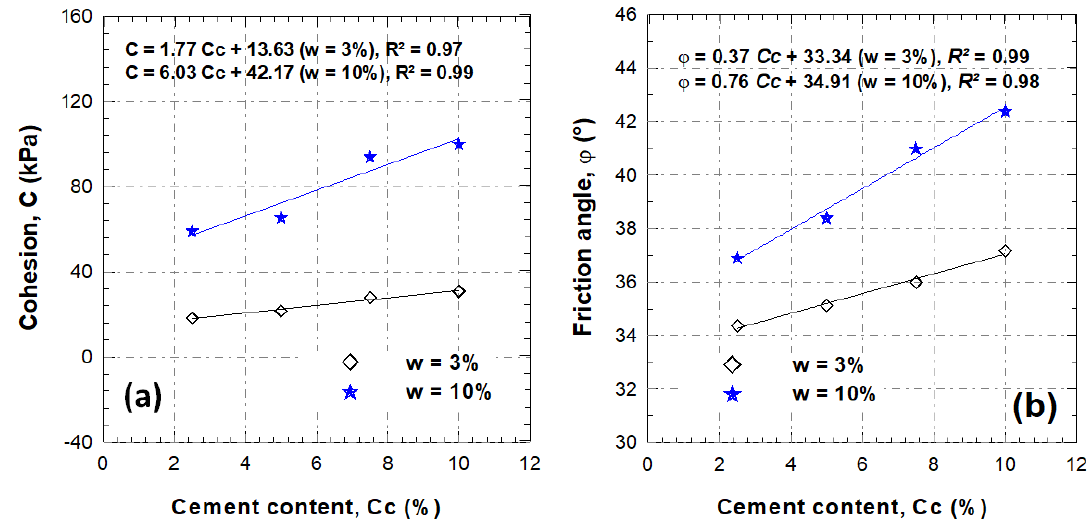
Figure 8: Influence of the cement content on the mechanical properties of cemented sand: (a) variation of the interlocking or intercept cohesion; (b) Variation of the friction